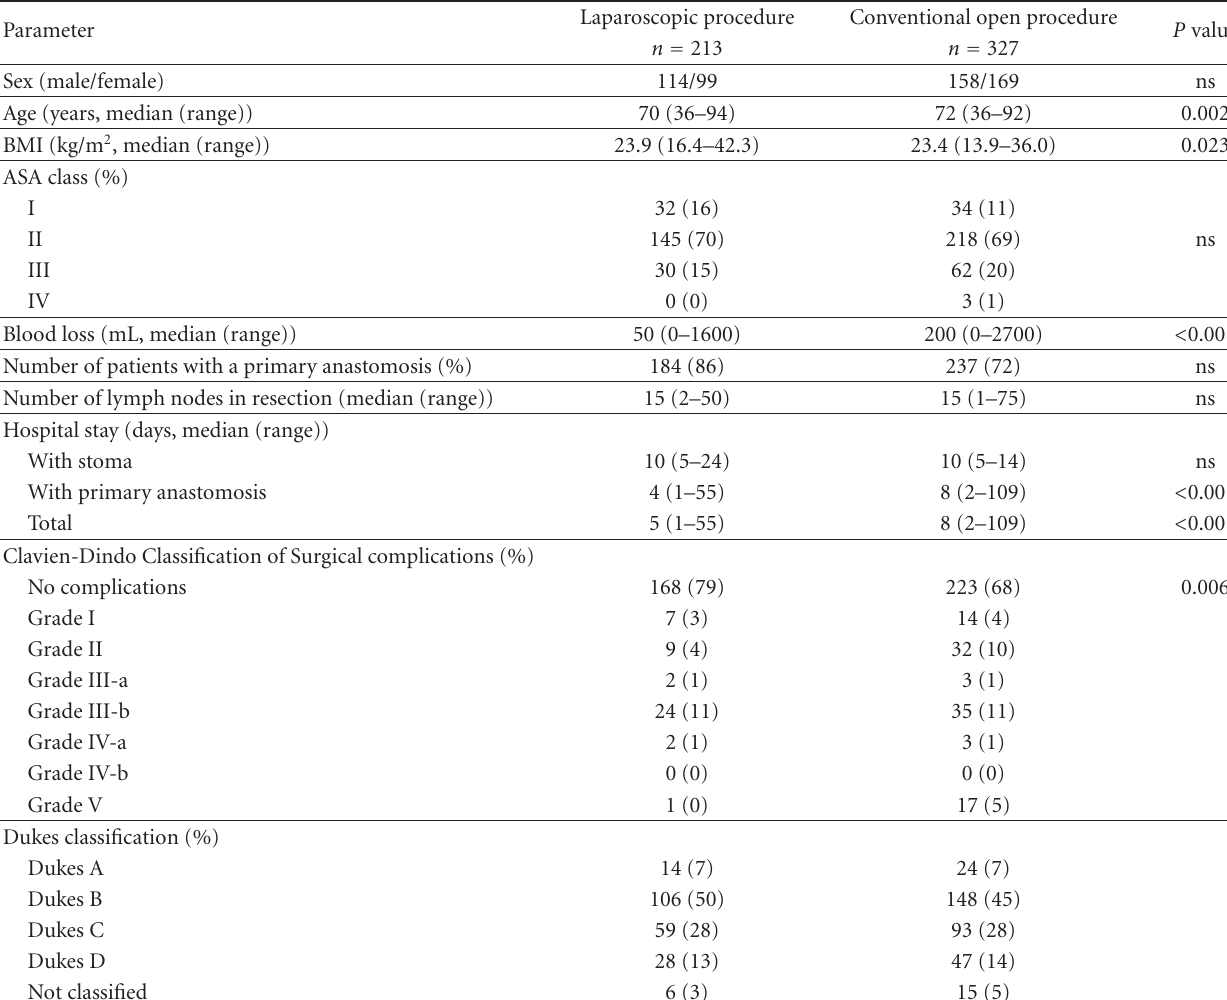
Table 1: Comparison of the 213 laparoscopic-treated patients with 327 patients treated with conventional open procedure in the same period (November 2004–December 2008) in our